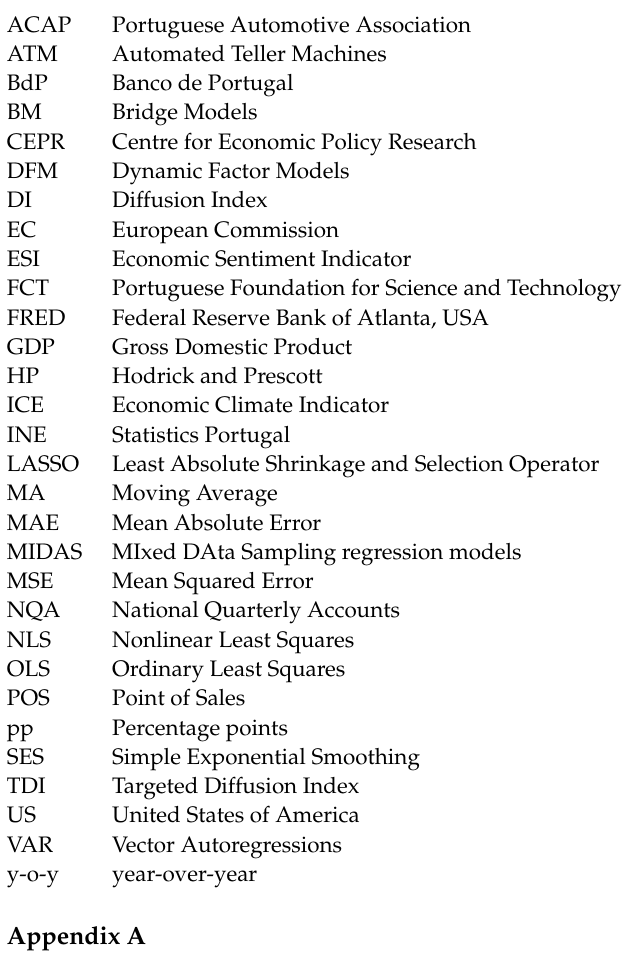
Table A1. Estimated coefficients (full sample